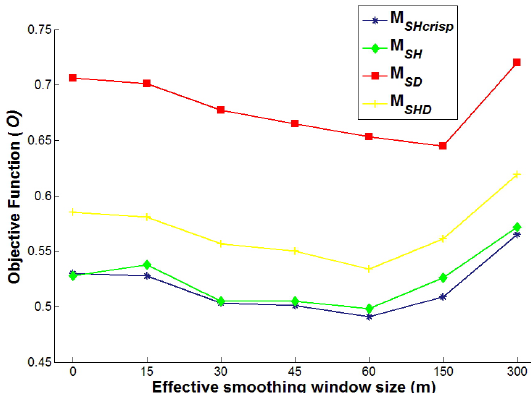
Fig. 5. Performance of different classification models for different effective smoothing window